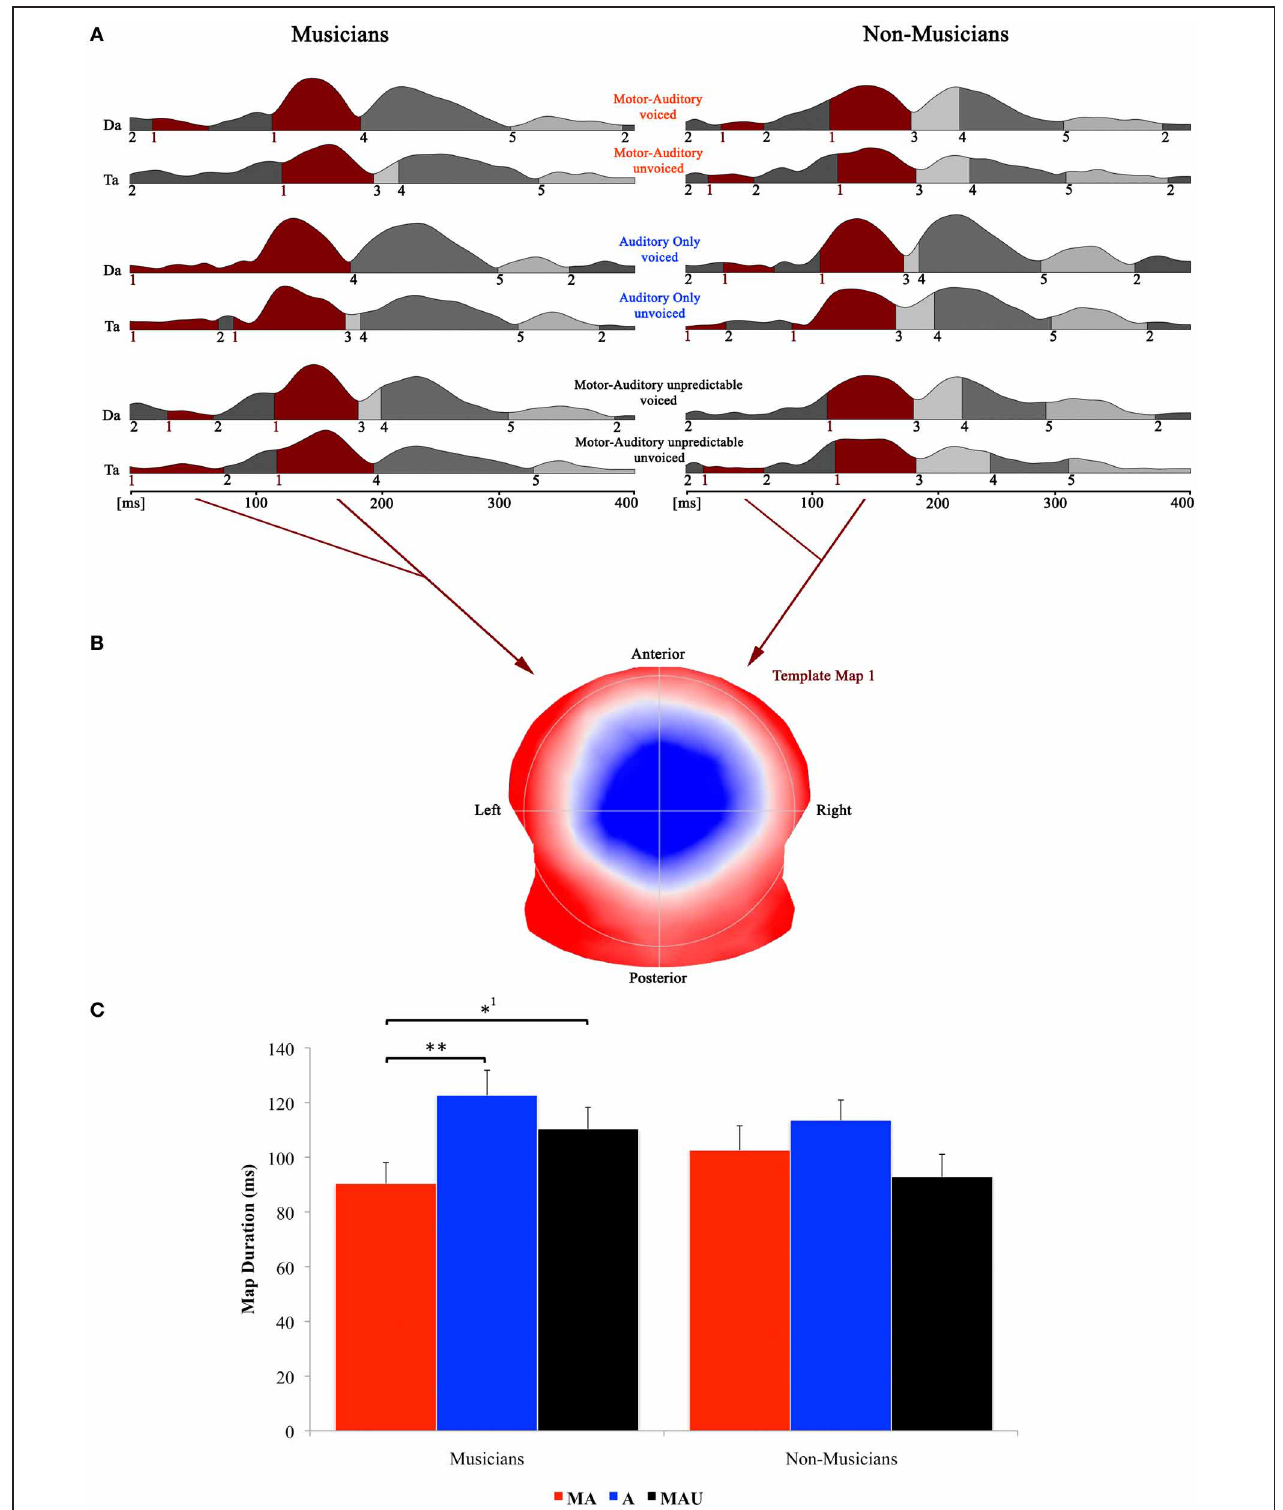
FIGURE 3 | Evoked potential data; speech condition. (A) Segments of stable map topography are shown group wise (left: musicians, right: non-musicians) for each condition under the global field power curve from 0 to 400ms. The numbers below the segmentation landscape indicate the